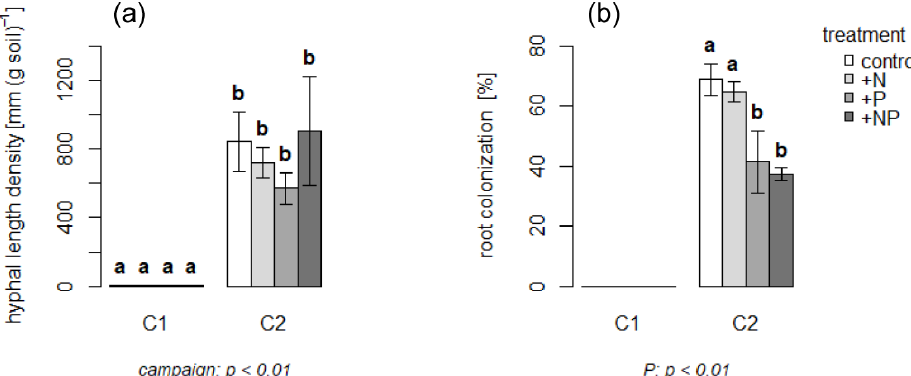
Figure 2. Means of mycorrhizal hyphal length (a) and root colonization (b) by time of C1 and C2. Error bars indicate standard error. Letters above bars indicate statistical differences. Significant effects are given with p value below the plots. Note that the values for C1 were (close to) zero, indicating that root colonization with AMF was